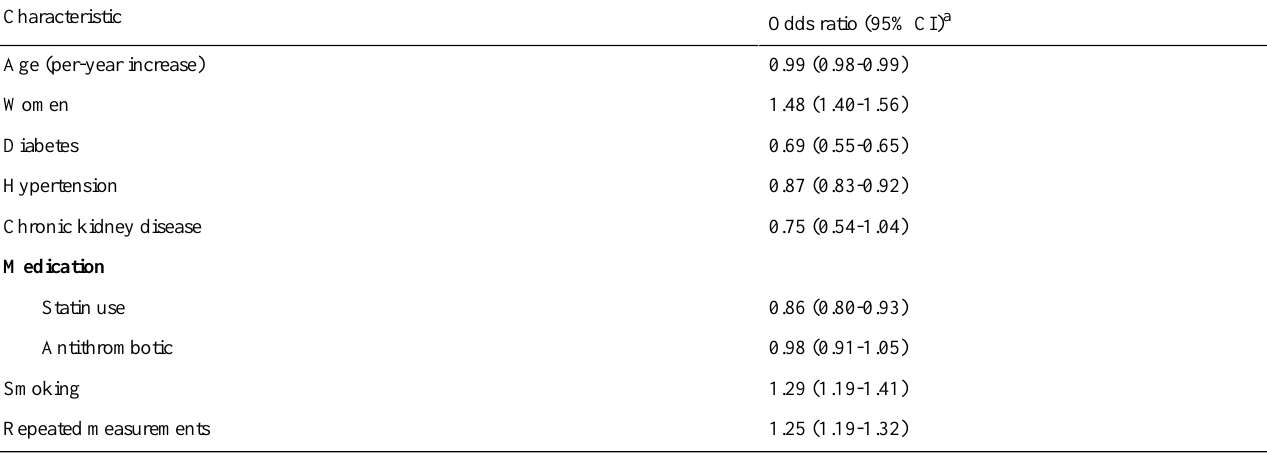
Table 2. Logistic regression: factors associated with being off target at first